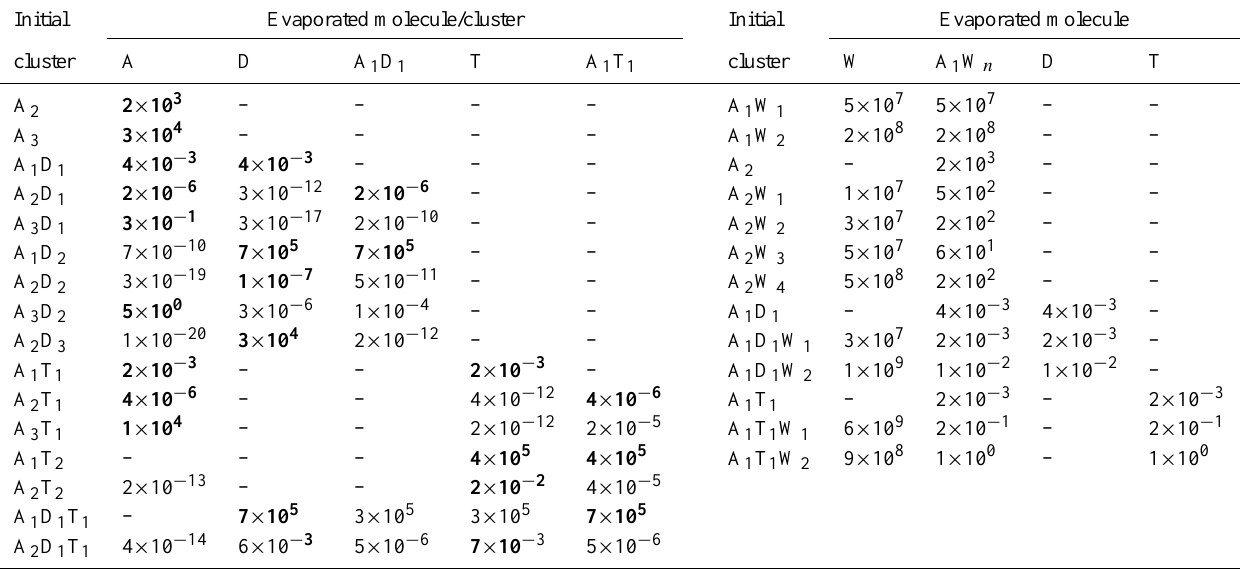
Table 2. Evaporation rates from the modelled clusters at T = 280 K in units [s − 1 ]. The highest evaporation rate from each cluster type is indicated with bold